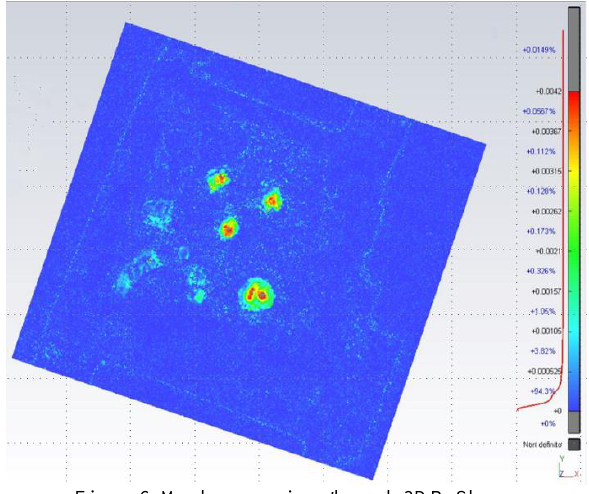
Figure 6. Mesh comparison through